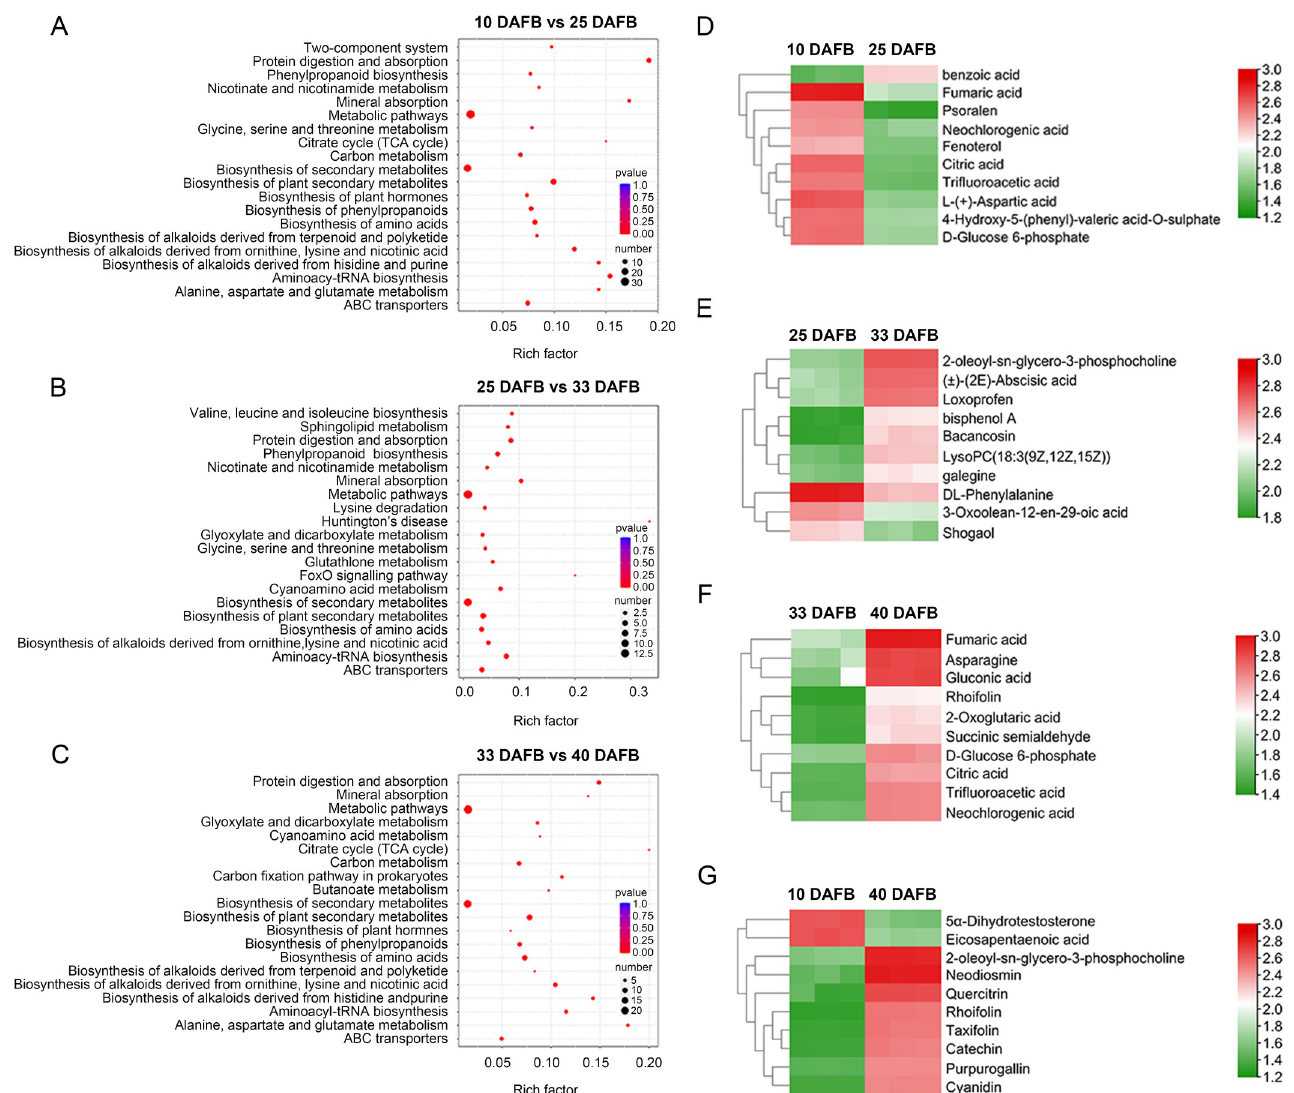
Fig 4. KEGG pathway enrichment analysis of DEMs in (A) 10 vs. 25 DAFB, (B) 25 vs. 33 DAFB, and (C) 33 vs. 40 DAFB. Heatmaps of top 10 DEMs in (D) 10 vs. 25 DAFB, (E) 25 vs. 33 DAFB, (F) 33 vs. 40 DAFB, and (G) 10 vs. 40 DAFB.